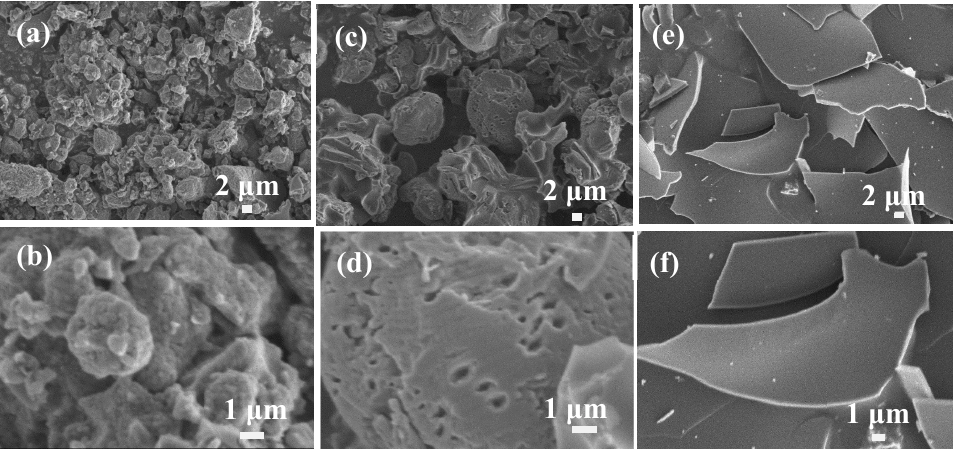
Figure 4. SEM images of lignin-based carbon materials using Longlive lignin as precursor in different types of activated solution: ( a,b ) 40 wt % KOH, ( c,d ) 40 wt % NaOH, and ( e,f ) 40 wt % H 3 PO 4 .